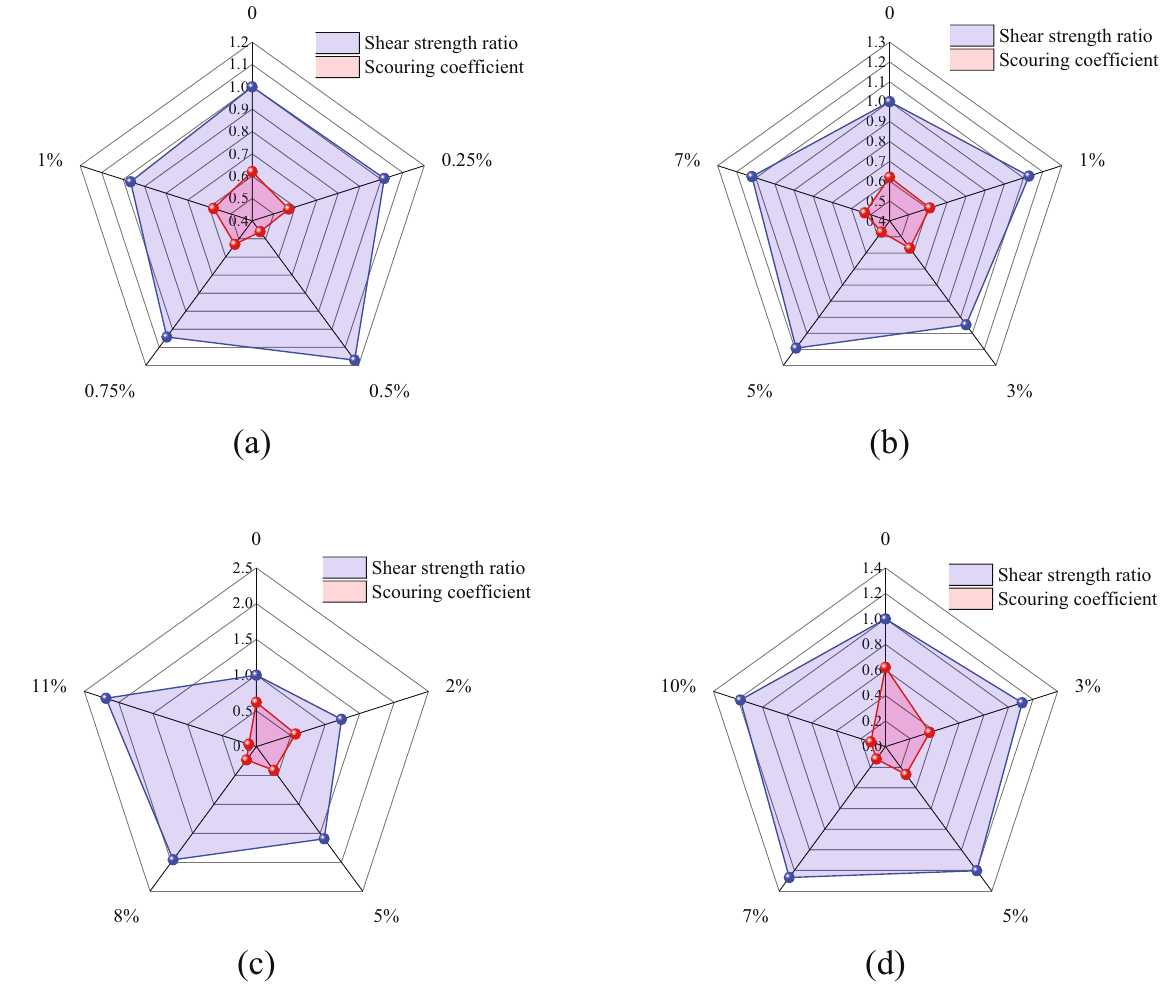
Figure 19: E ff ect of improving yellow mud with di ff erent materials: ( a ) straw; ( b ) starch; ( c ) cement; and ( d ) epoxy